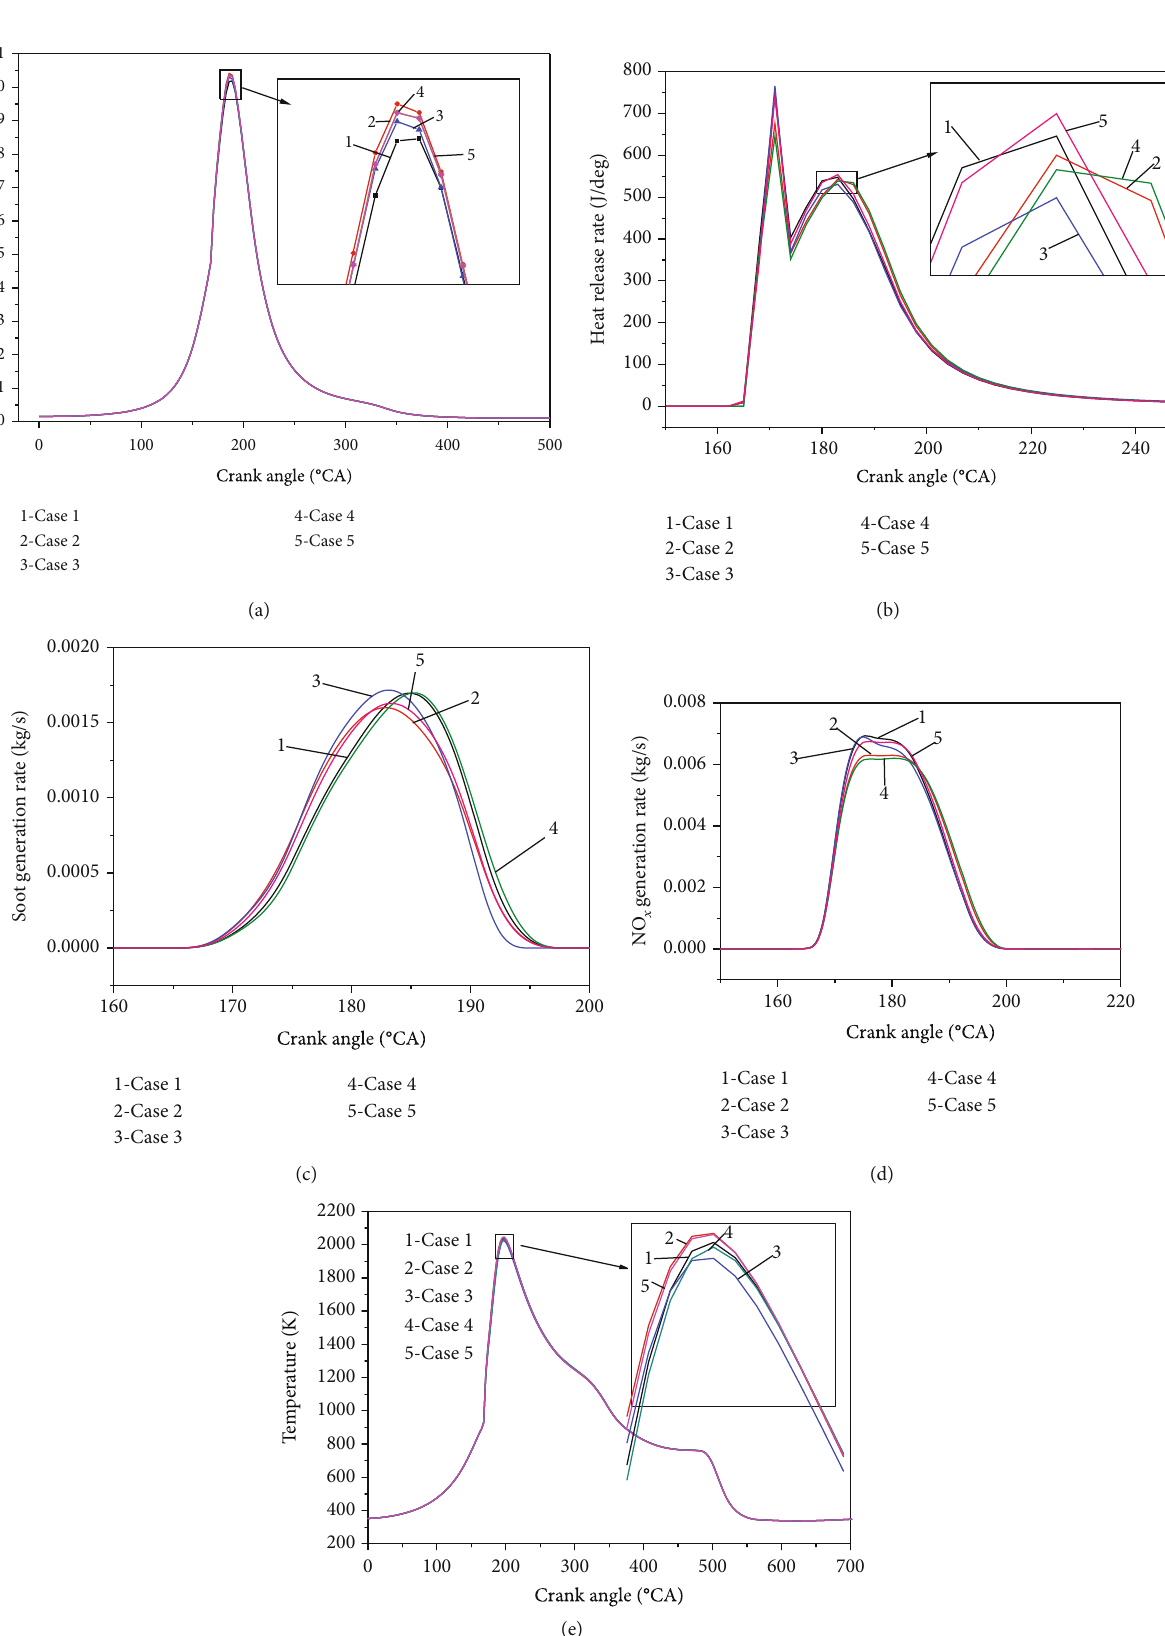
Figure 10: E ff ect of injection rate on diesel